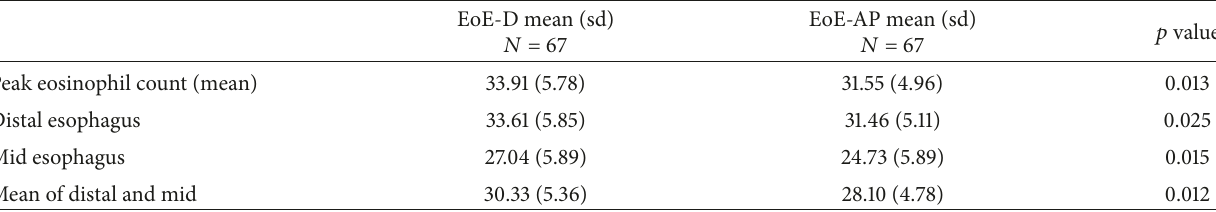
Table 4: Eosinophil counts on the esophageal biopsies.